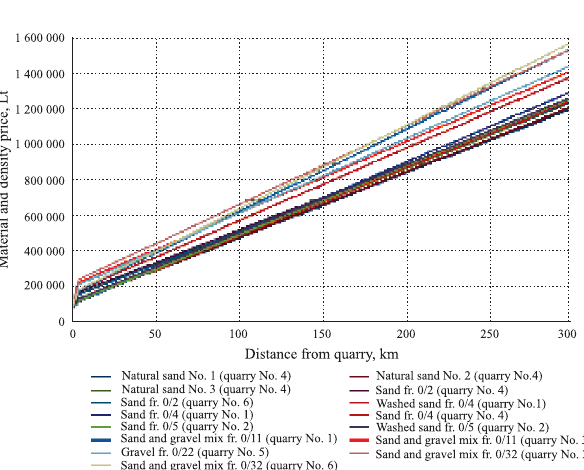
Fig. 6. Relationship between the costs of laying a frost blanket course, the materials and their transportation distance up to 300 km (1 Lt = 3.4528